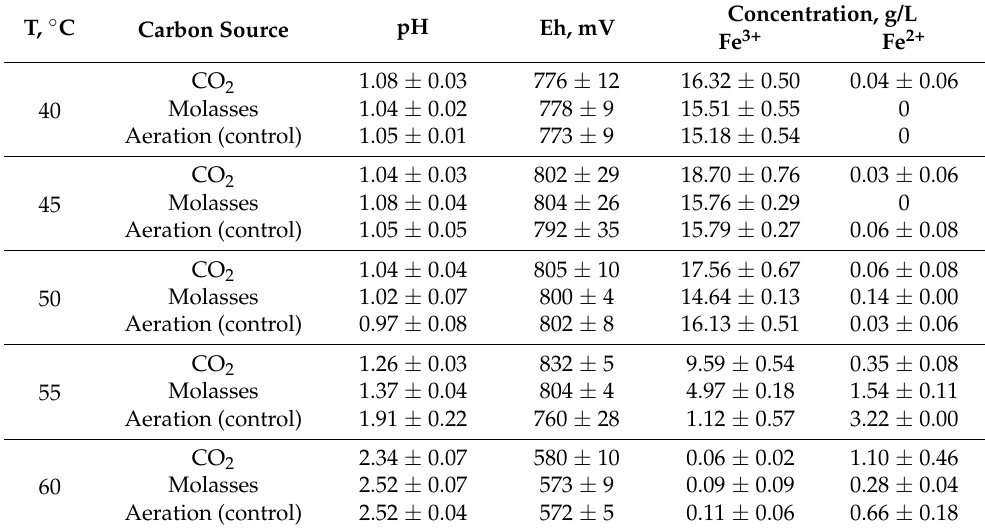
Table 2. Parameters (pH, Eh, ferric and ferrous ion concentration) of the liquid phase of the pulp at the end of the experiment (steady state conditions).